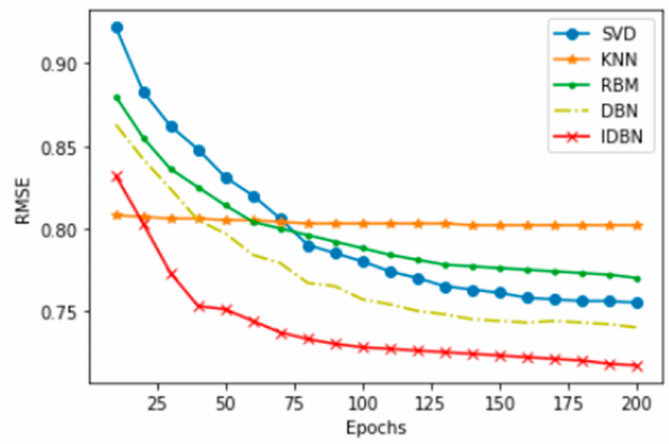
Figure 10. The accuracy of the recommendation